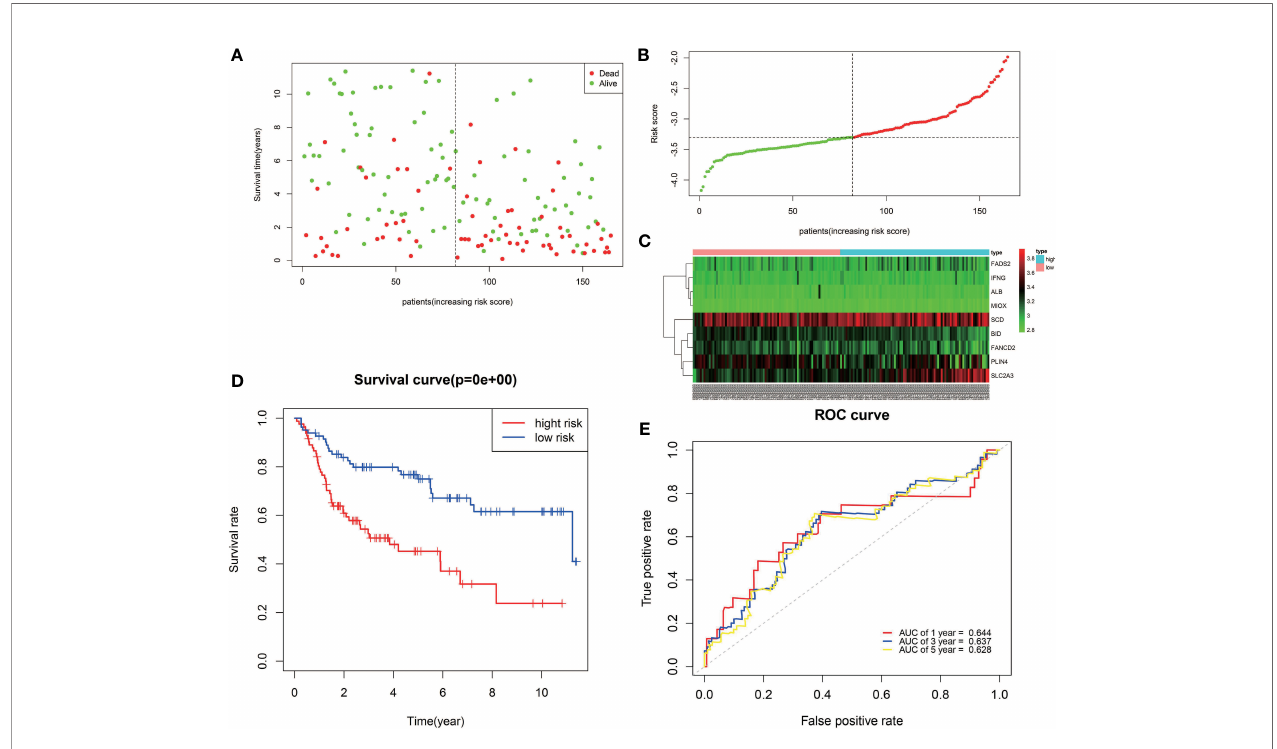
FIGURE 4 | Validation of the nine-FRG signature in the GEO cohort. (A) Survival status of high-risk and low-risk patients. (B) Distribution of risk scores. (C) The differences in the expression of the prognostic signature in different risk groups. (D) Kaplan – Meier curves for OS. (E) Time-dependent ROC curve